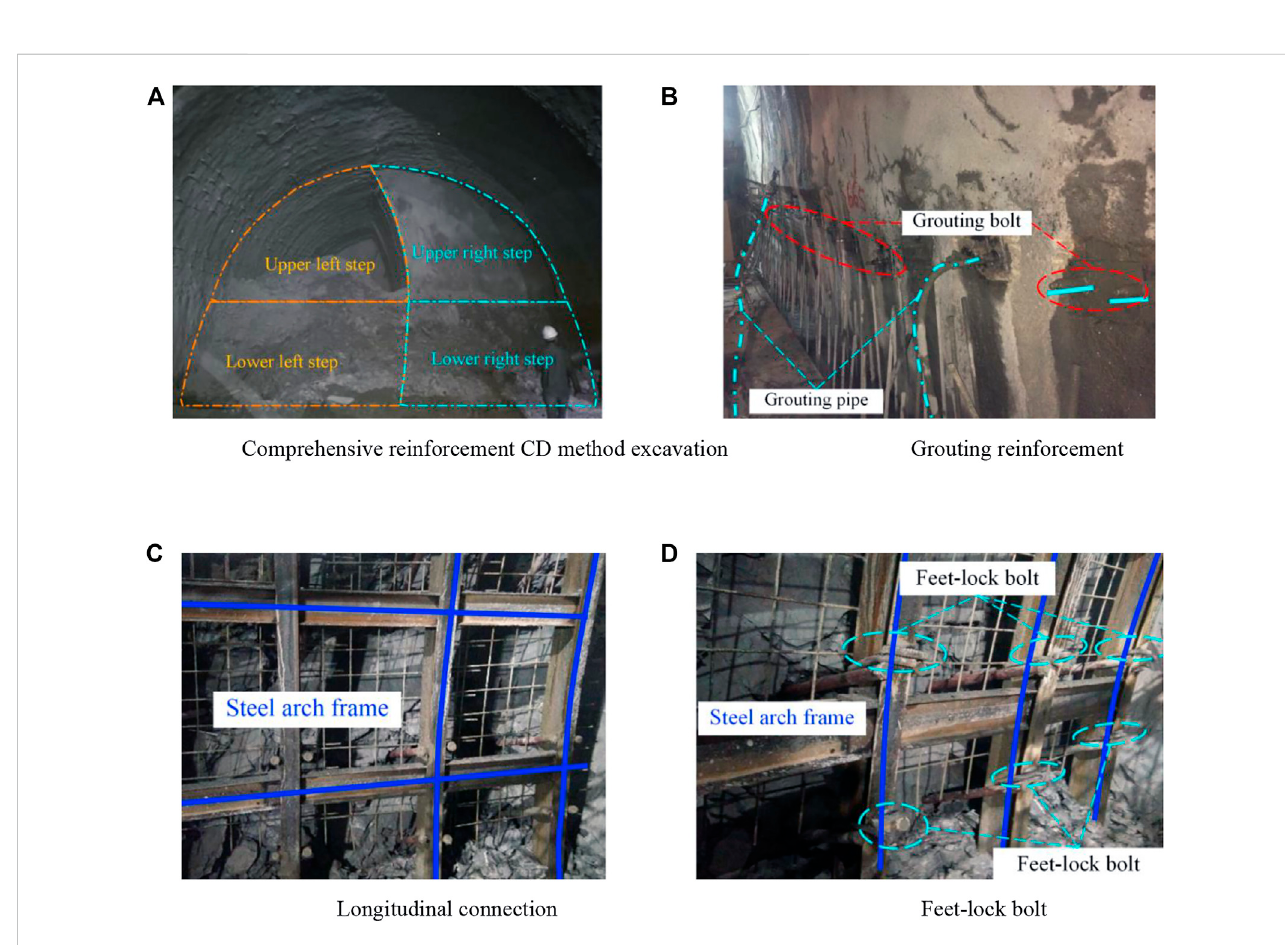
FIGURE 10 Comprehensive reinforcement CD method construction and supporting structure. (A) CD method excavation. (B) Grouting reinforcement. (C) Longitudinal connection (D) Feet-lock